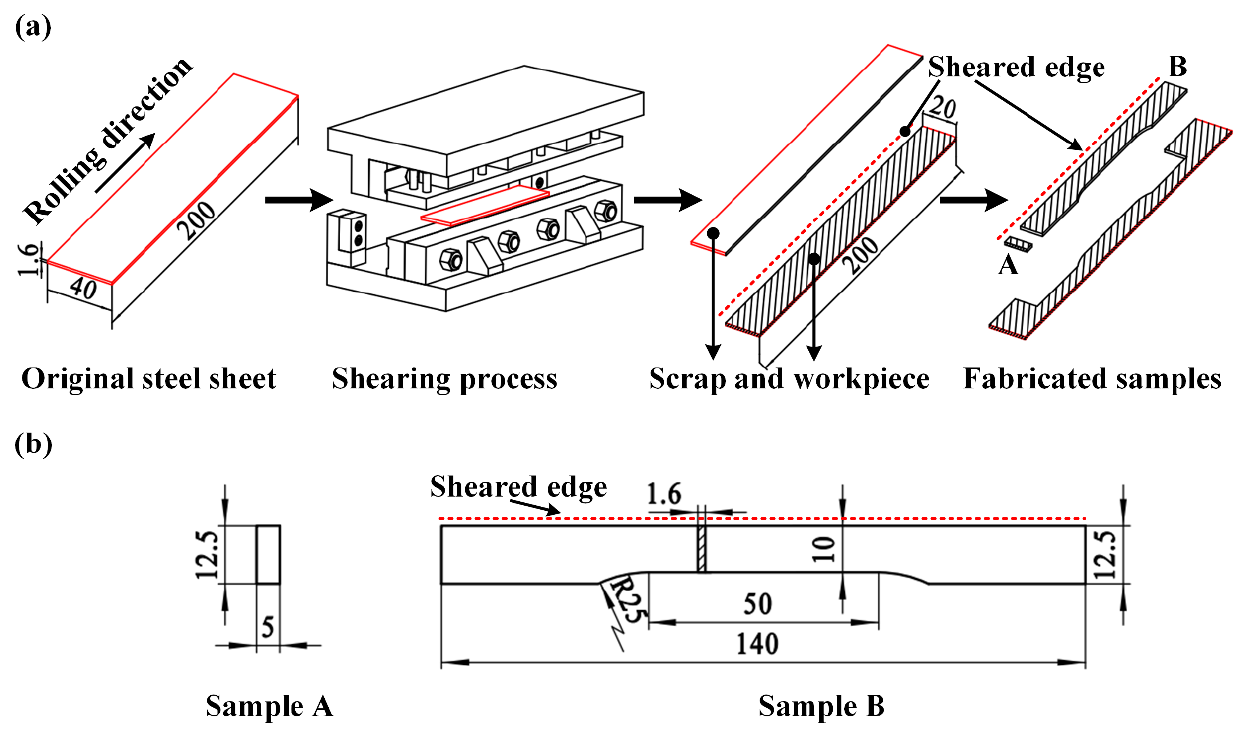
Figure 3. ( a ) Experimental procedure. ( b ) Sample dimensions (all units are in mm).